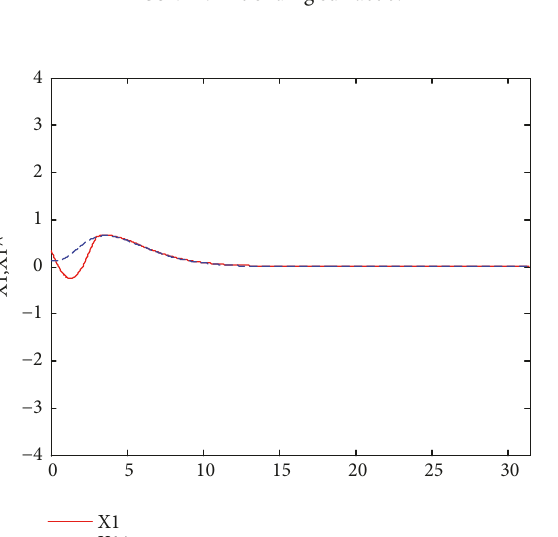
Figure 2: The sliding surface 𝑠 .